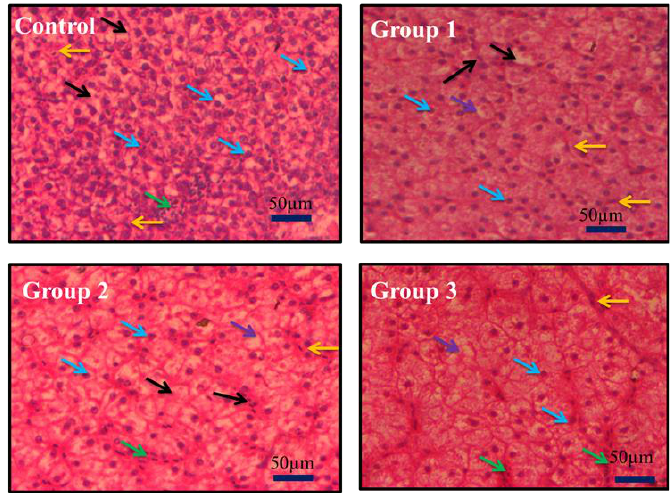
Figure 5. Representative histological liver sections [Phase contrast Nikon microscope magnification at 40 × ] of Oreochromis mossambicus exposed to polypropylene microplastics after 14 days at 100